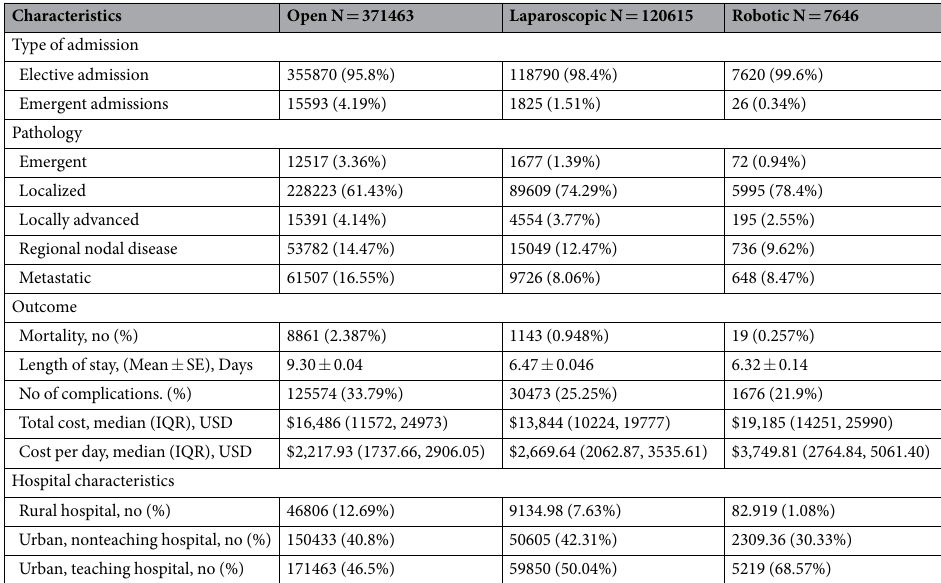
Table 2 aggregates patient characteristics and outcomes from the same surgical treatment modality from 2008 to 2012. The three types of surgeries were mainly performed on elective admission (open 95.8%, laparoscopic 98.4%, and 99.6%) and patients with localized cancer (open 61.4%, laparoscopic 74.3% and robotic 78.4%). However, open surgery was selected against the other surgeries for regional or distant cancer, and emergency surgery. Open surgeries have the highest percentage of patients with emergent pathology, locally advanced disease, regional nodal disease, and metastatic disease. For the type of hospital conducting the surgery, most of the surgeries are conducted in